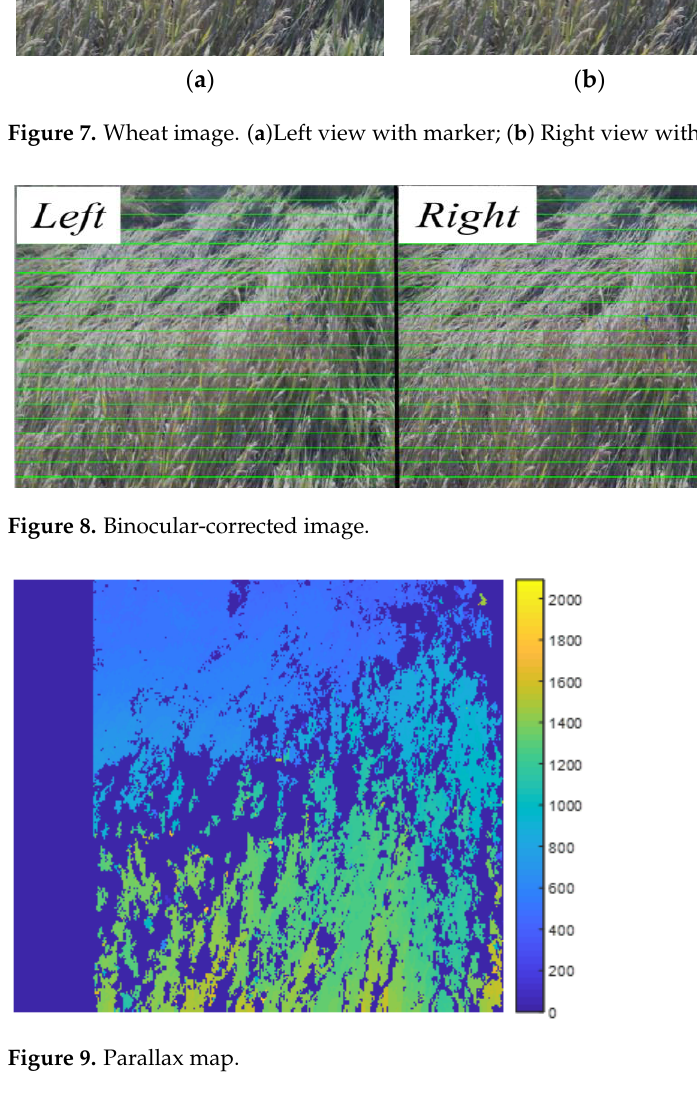
Figure 9. Parallax map.